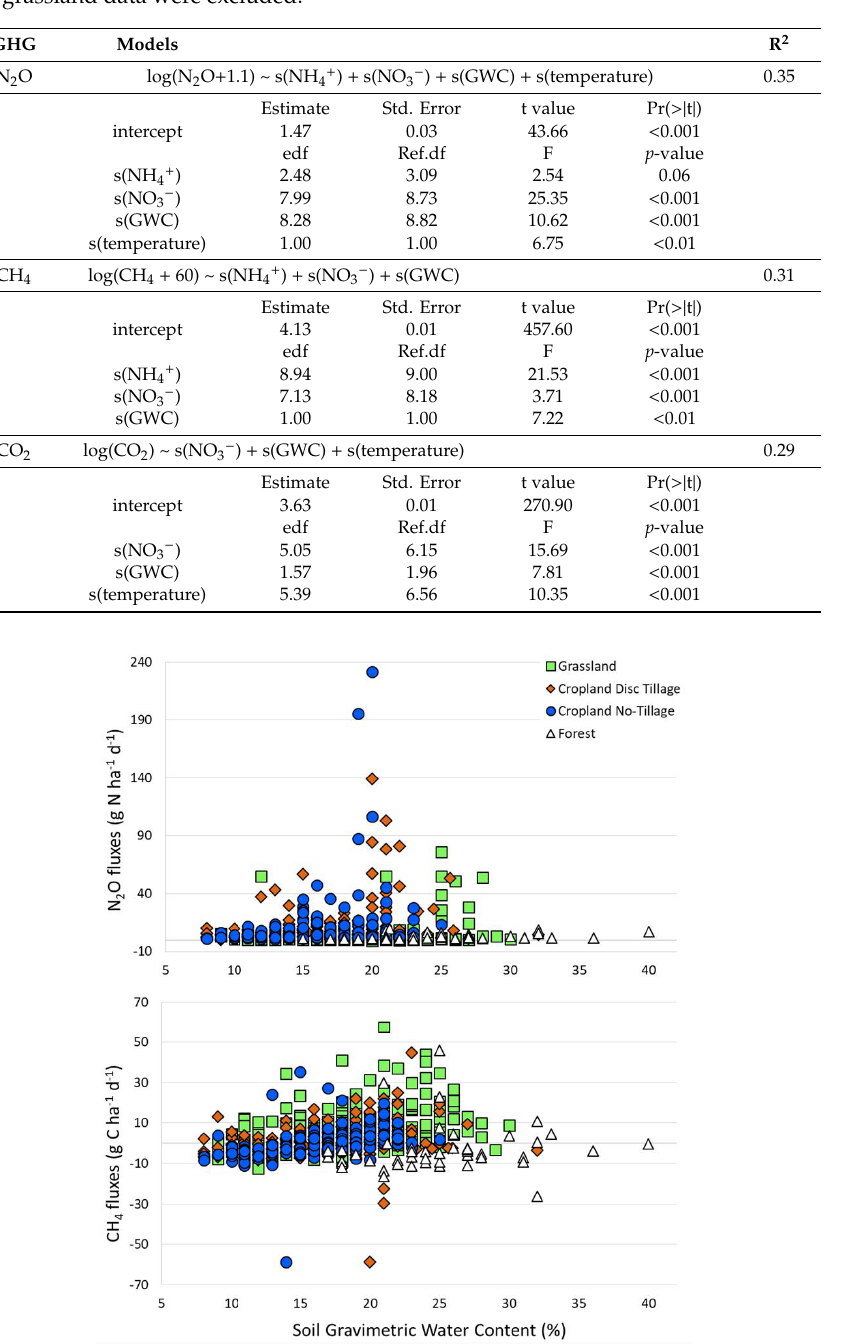
Table 4. Summary of the generalized additive models fitted for each GHG as a function of soil nitrate content (NO 3 − ), soil ammonium content (NH 4 + ), soil gravimetric water content (GWC), and soil temperature. For N 2 O and CH 4 fluxes, data of grassland and both croplands were used. For CO 2 emissions, grassland data were excluded.